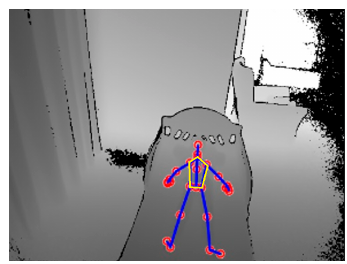
Figure 3. Skeletal joints provided in the Kinect code library. The Region of interest is the yellow pentagon defined by the 5 points.